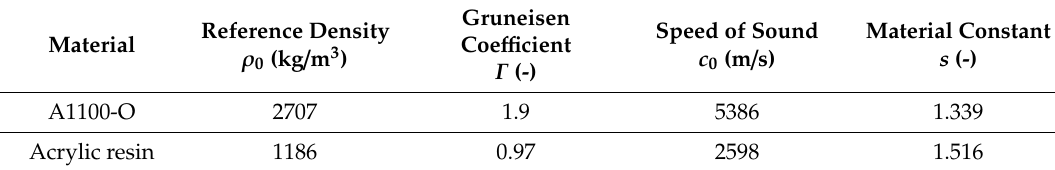
Table 3. Values for the Mie–Gruneisen equation of